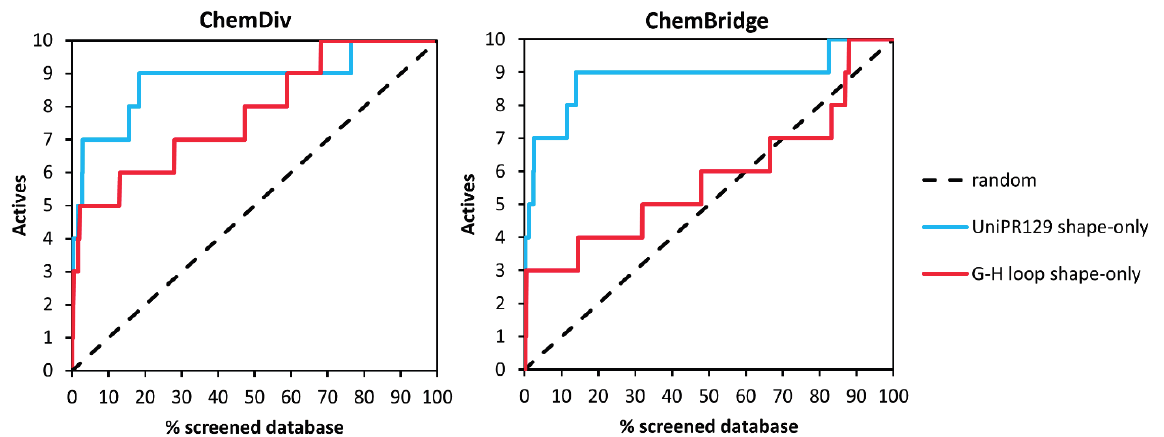
Figure 6. Enrichment curves obtained from shape screenings performed on ChemDiv (left ) and Chembridge ( right )